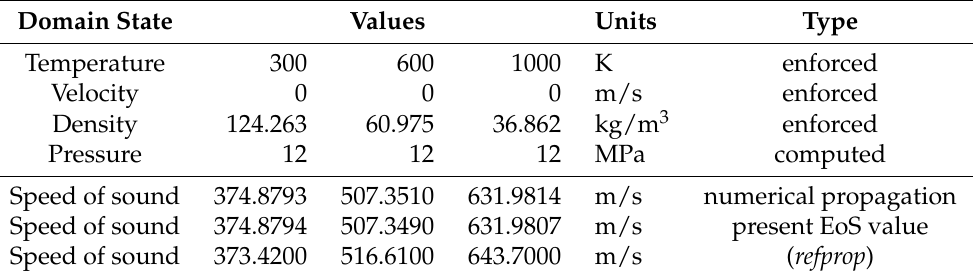
Figure 9. Simple wave propagation problem in a quiescent tube. Velocity is small enough to assume linear behavior of the flow field. The speed of sound is deduced by numerically measuring how long it takes for the signal to propagate back and forth in the tube. Mixture is O 2 - CH 4 with O/F = 3.4, pressure is 12 MPa, while temperature is 300 K. Table 5. Duct thermodynamic state during acoustic propagation tests. Mixture is made of O 2 - CH 4 with O/F =